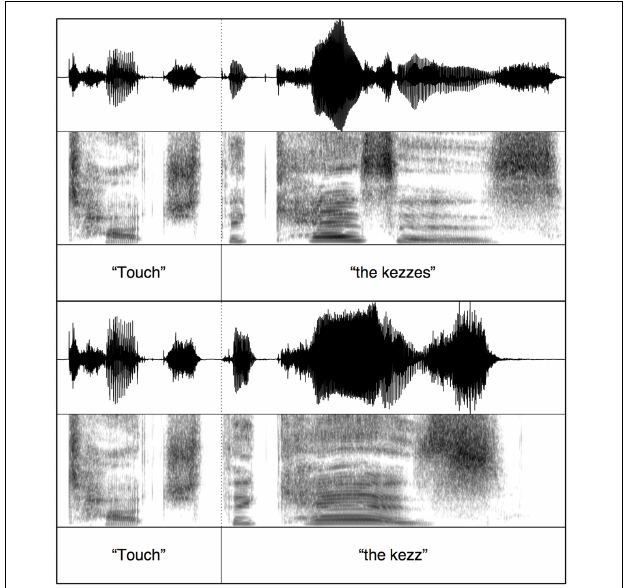
FIGURE 3 | Example stimulus splicing for auditory stimuli with syllabic morpheme / @ z/.